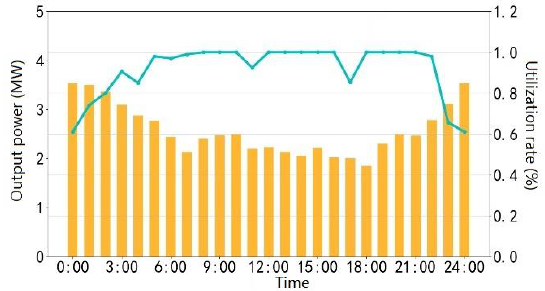
Figure 7. Operation of wind turbine in a typical day.